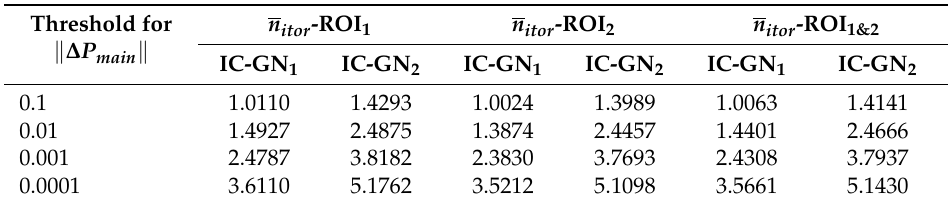
Figure 5. Measured displacement errors ( s U , RMSE U ) under different convergence criteria: ( a ) Standard deviation as a function of convergence threshold for (cid:107) ∆ P main (cid:107) ; and ( b ) RMSE as a function of convergence threshold for (cid:107) ∆ P main (cid:107) . Table 2. Comparison of average number of iterations of matched pixels in ROI 1 , ROI 2 , and ROI 1&2 with different convergence thresholds for IC-GN 1 and IC-GN 2